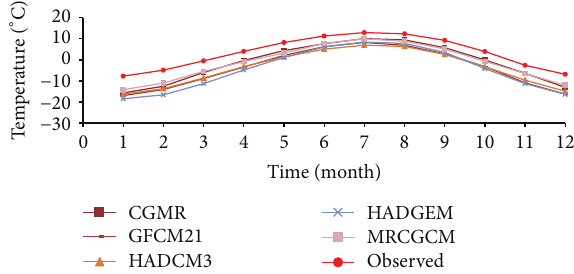
Figure 7: Comparison of precipitation simulated by the six best- performance